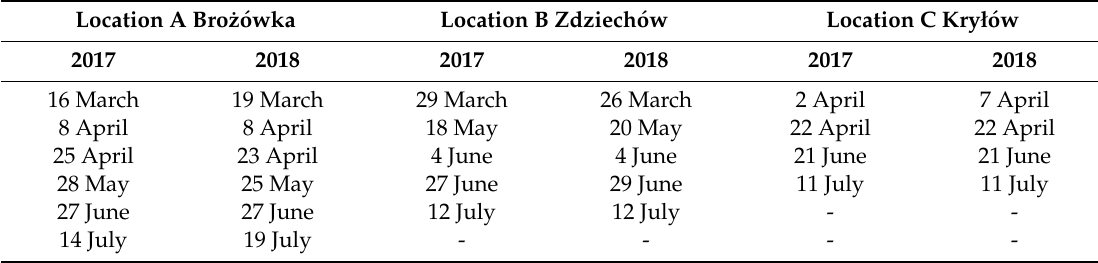
Table 2. Dates for which satellite-based vegetation indices were derived from Sentinel images for three locations and two